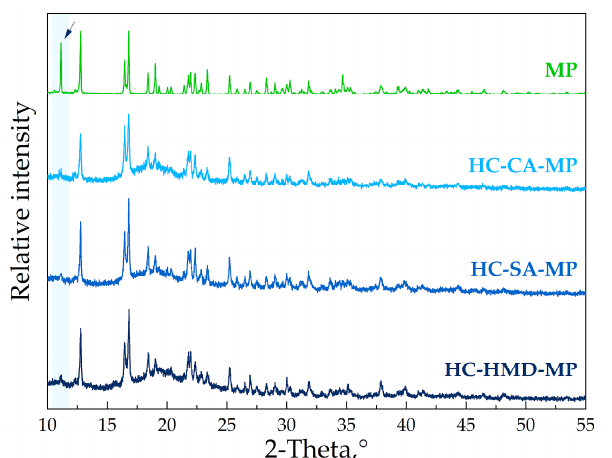
Figure 5. Experimental PXRD patterns for MP, HPCD-CA-MP, HPCD-SA-MP, and HPCD-HMD-MP. No more signals were detected from 55 ° to 80 ° .